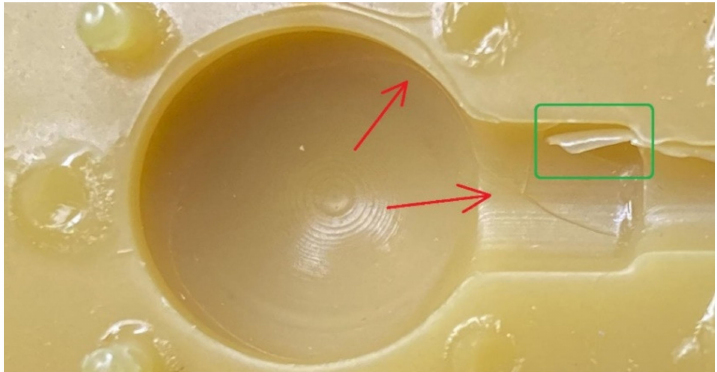
Figure 9. A magnified image of the printed male half of the die. Red arrows indicate cracks. The green box encompasses the flaking